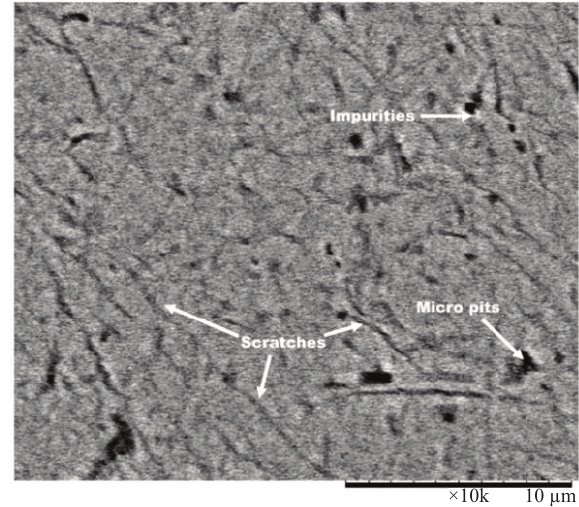
Fig. 2. Alumina ball SEM image.